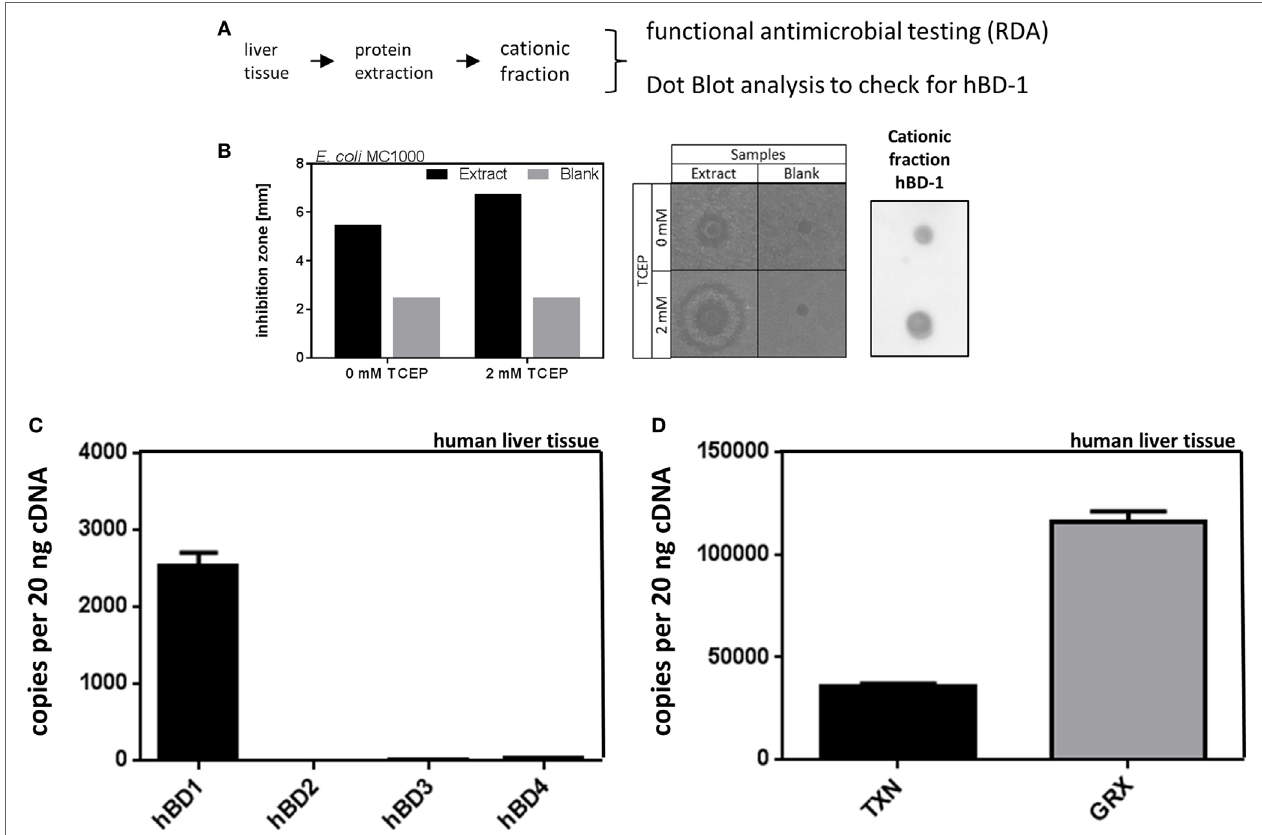
FigUre 1 | Antimicrobial activity of liver protein extract is accompanied by high expression of hBD-1 and oxidoreductases in human liver tissue. (a) Schematic workflow of cationic protein extraction from liver tissue, which was tested for antimicrobial activity [radial diffusion assay (RDA)] and hBD-1 status (by dot blot analysis). (B) On the left panel, quantitative results of RDA inhibition zones of cationic protein extract and blank extract (without liver tissue) under reducing (2 mM TCEP) or non-reducing conditions (0 mM TCEP) are depicted. In the middle panel, the respective RDA results are shown as picture. On the right panel, dot blot results with hBD-1 primary antibody to confirm hBD-1 peptide in cationic protein extract are shown. (c) mRNA expression of hBD-1, hBD-2, -3, and -4 was analyzed in a human patient cohort without cholestasis or systemic inflammatory response ( n = 120). mRNA transcript levels are measured in an amount of 20 ng cDNA. Total copy numbers are depicted. Data are presented as means ± SEM for each gene assay. (D) mRNA expression of TXN and GRX in human liver tissue ( n = 120). mRNA transcript levels are measured in an amount of 20 ng cDNA. Total copy numbers are depicted. Data are presented as means ±